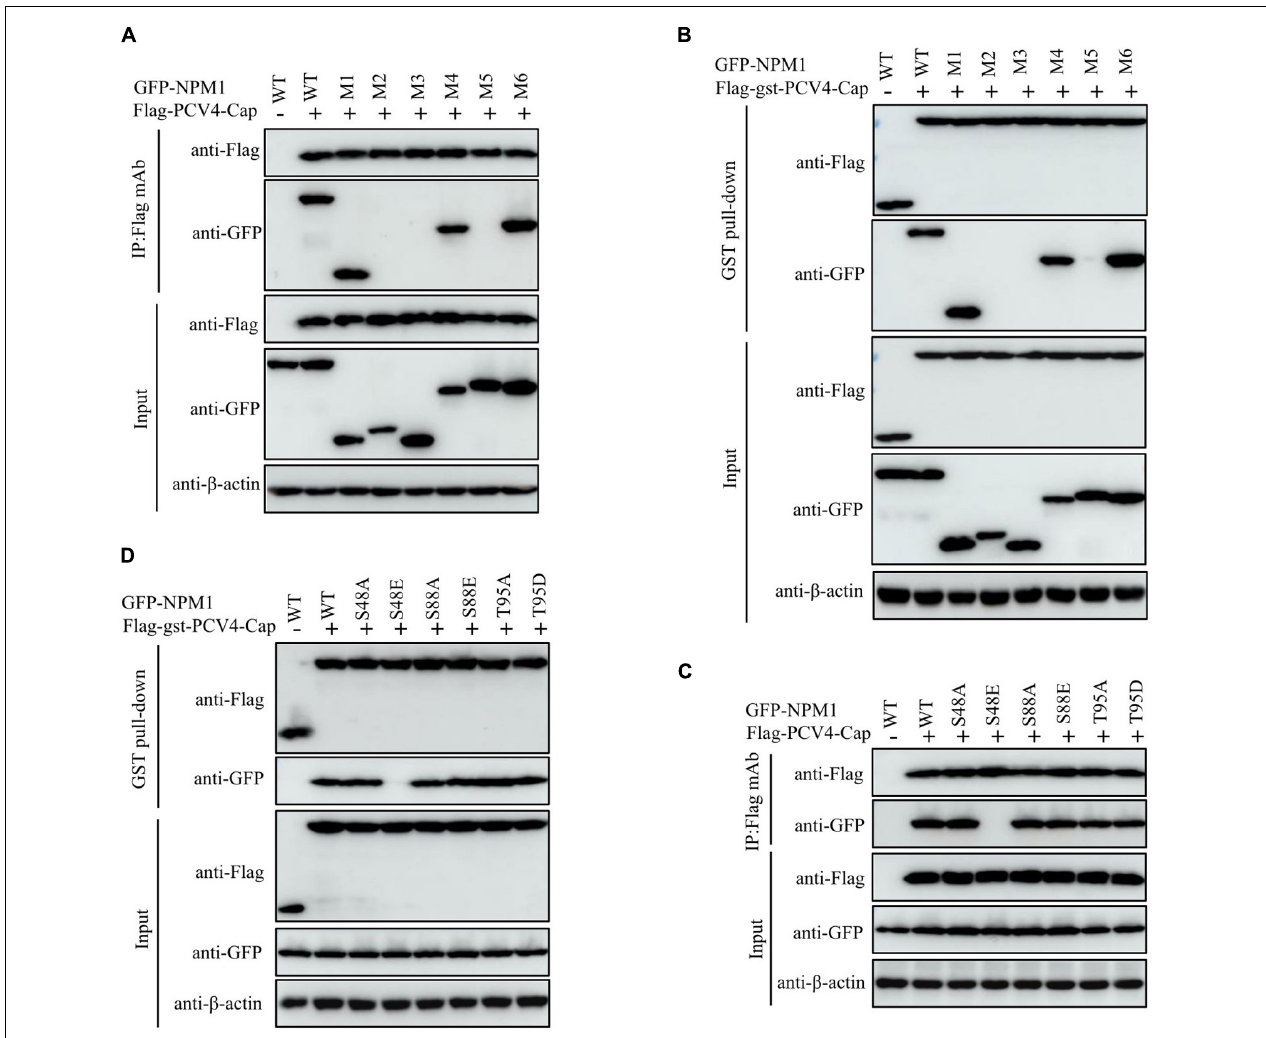
FIGURE 4 | NPM1 serine-48 is crucial for binding to PCV4 Cap. (A,B) The NPM1-OligoD (1–117 aa) interacted with PCV4 Cap. HEK293T cells were co-transfected with expression plasmids GFP-NPM1-WT or its serial GFP-NPM1 truncated mutants M1 to M6, together with the Flag-PCV4-Cap or Flag-gst-PCV4-Cap plasmid. The cell lysate extracts were immunoprecipitated or subjected to a GST pull-down assay followed by western blotting using the indicated antibodies. (C,D) Mapping the critical amino acids of OligoD required for interaction with PCV4 Cap. HEK293T cells were co-transfected with NPM1 or NPM1 mutant plasmids (NPM1-S48A, NPM1-S48E, NPM1-S88A, NPM1-S88E, NPM1-T95A, or NPM1-T95D), together with the Flag-PCV4-Cap or Flag-gst-PCV4-Cap plasmid, and the cell lysate extracts were immunoprecipitated or subjected to a GST pull-down assay followed by western blotting using the indicated